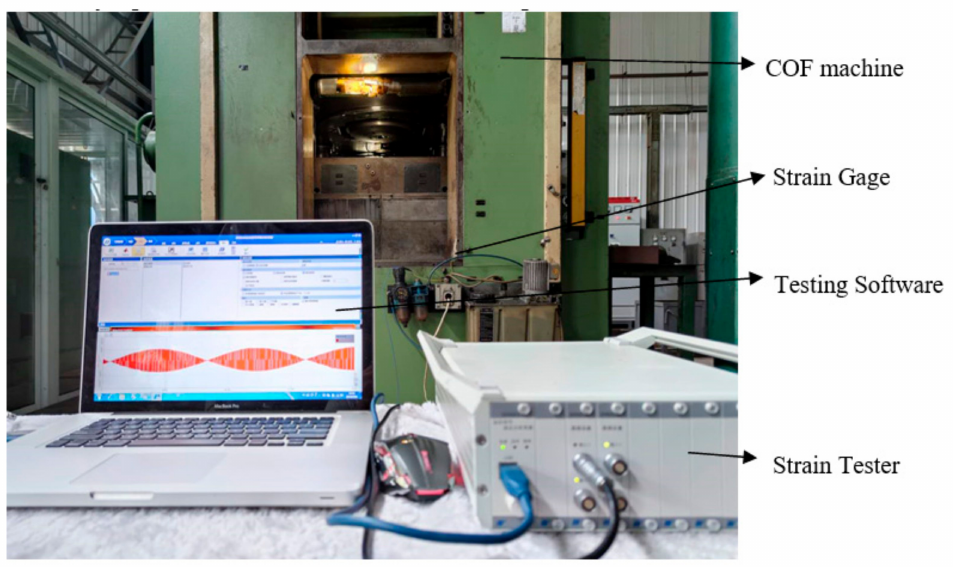
Figure 16. Strain test experiment.